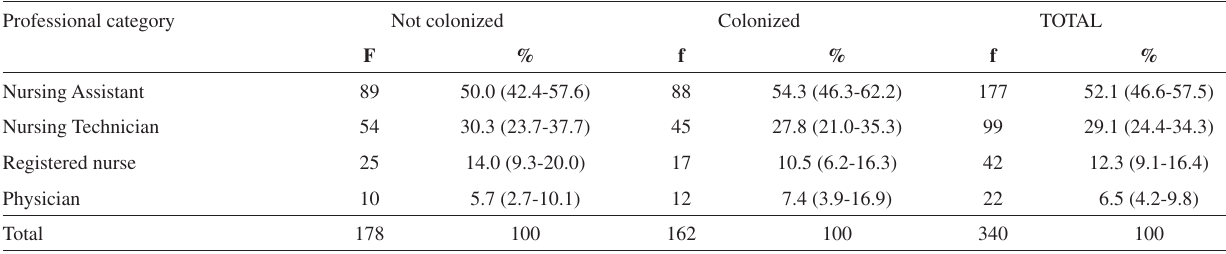
Table 1 - Distribution of participants according to professional category and colonization by S. aureus, 2007-2008